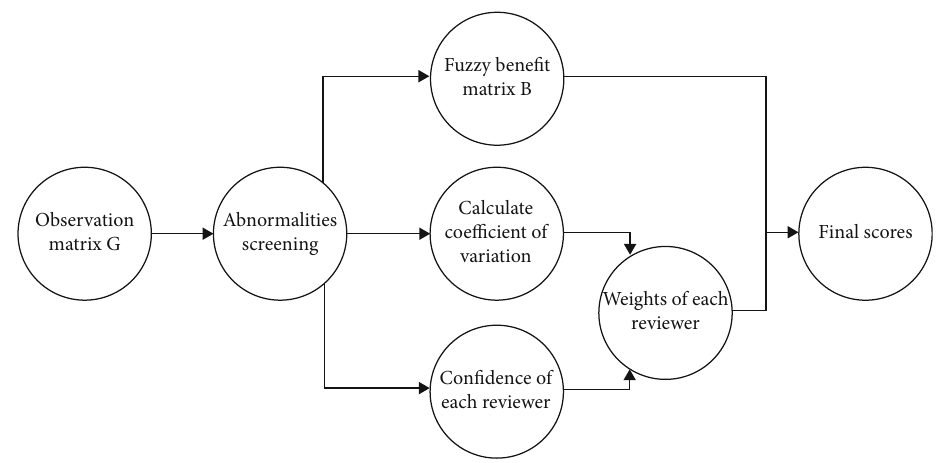
Figure 2: Flow chart of calculating students ’ fi nal scores via fuzzy synthetic